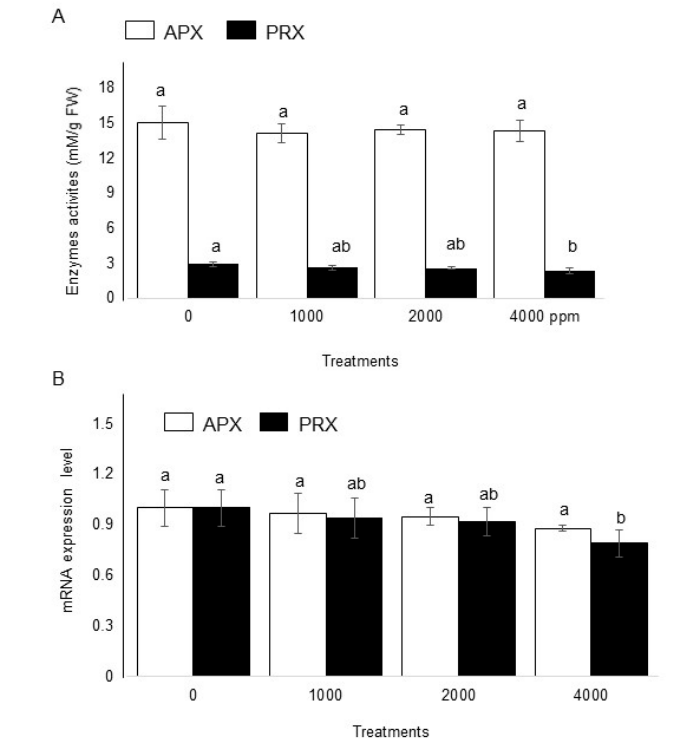
Figure 7. Effect of plant-derived smoke on enzymatic analysis and expression level of ascorbate peroxidase and peroxiredoxin gene in maize shoot. Maize seeds were treated without or with 1000 ppm, 2000 ppm, and 4000 ppm plant-derived smoke for 6 h and sown. Activities of ascorbate peroxidase (APX) and peroxiredoxin (PRX) were measured in 4-day old maize shoot ( A ). For gene expression level, RNAs extracted from maize shoot at 3rd day of treatment were analyzed by qRT-PCR ( B ). Relative mRNA abundances of ascorbate peroxidase and peroxiredoxin were normalized against 18S rRNA abundance. The data are shown as means ± S.D. from 4 independent biological replicates. White and black bars indicate ascorbate peroxidase (APX) and peroxiredoxin (PRX), respectively. Different letters indicate that the change is significant as determined by one-way ANOVA followed by Tukey’s multiple comparison ( p <